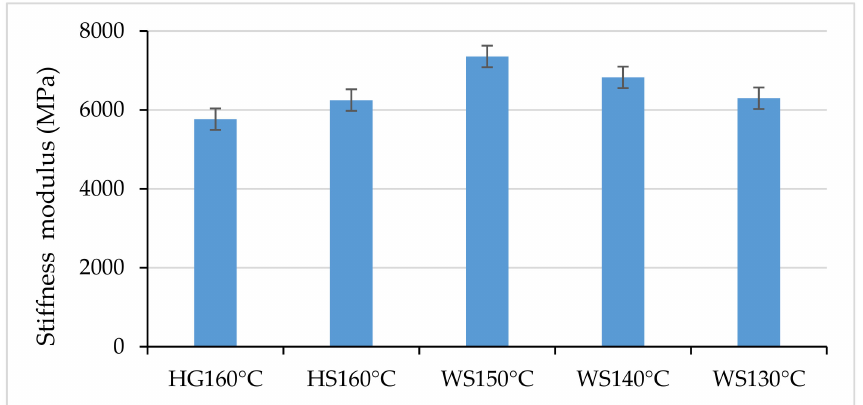
Figure 3. Stiffness modulus and the standard error bars of the mixes at 25 ◦ C.